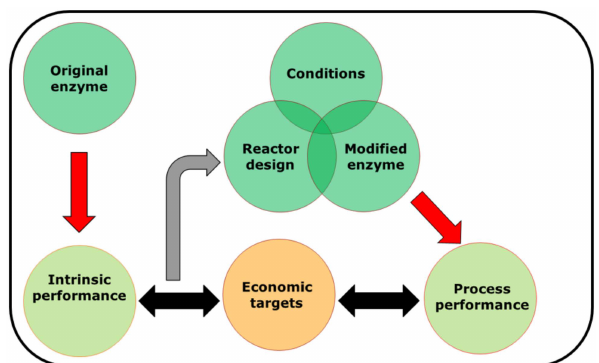
Figure 2. Schematic representation of strategy for repeated measurement of biocatalyst performance (biocatalyst yield, productivity, achievable product